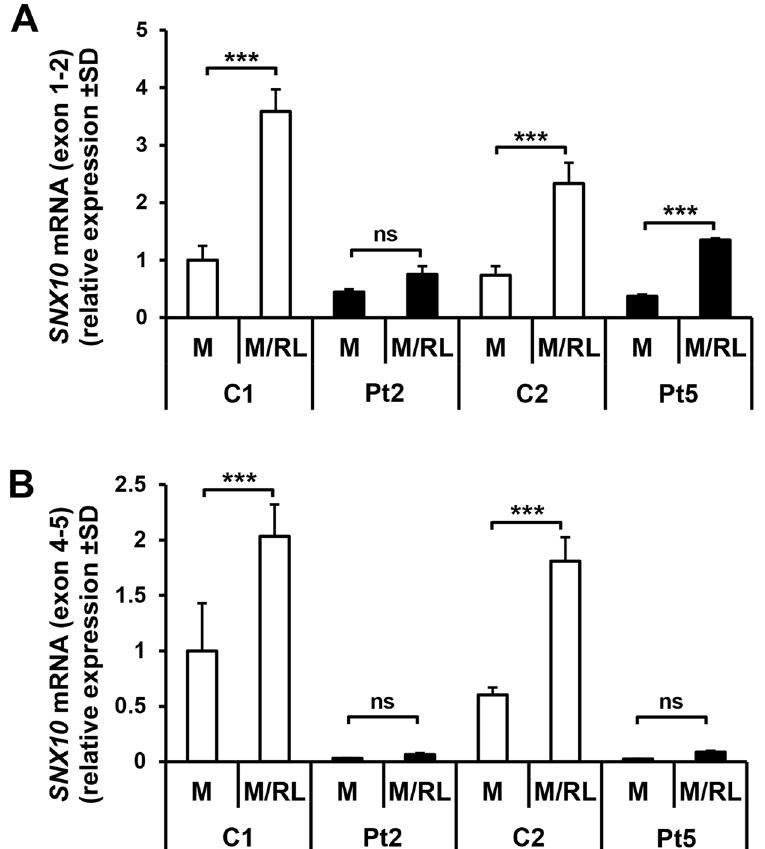
Figure 6. Expression of SNX10 mRNA in cells treated with M or M/RL for three days, analyzed with an assay covering the exon 1–2 ( A ) and exon 4–5 ( B ) junction. Values are given as mean ± SD (n = 2–4). *** P ≤ 0.001 between M and M/RL treated